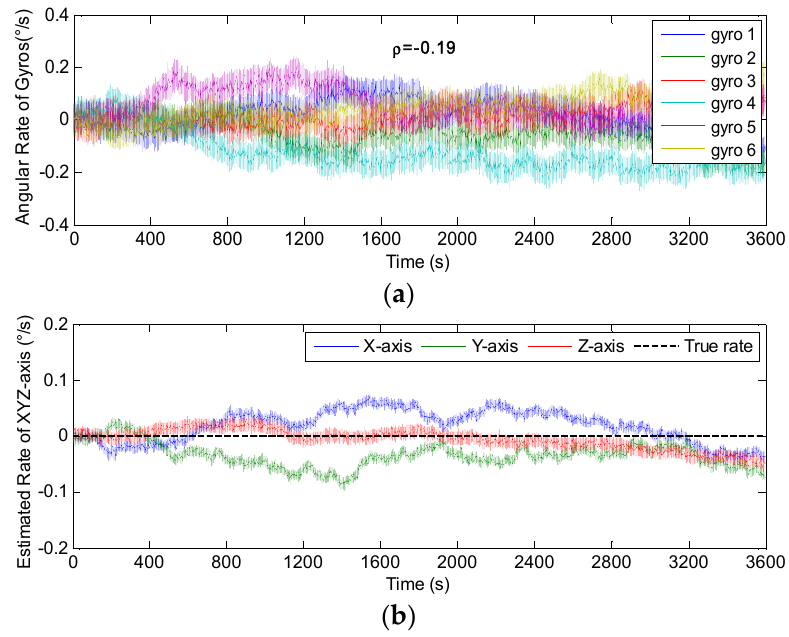
Figure 12. Fused results of the 6-gyro MIMU system for Scheme 1 ( ρ = − 0.19). ( a ) The output of gyros. ( b ) The estimated result of the MIMU.